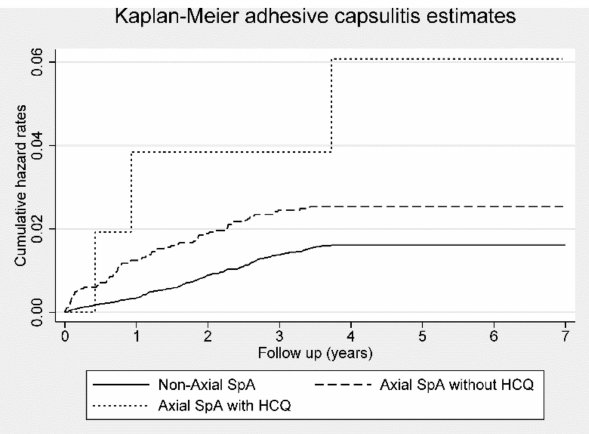
Figure 5. Kaplan–Meier hazard curve for adhesive capsulitis in patients with axial spondyloarthritis (Axial SpA) with or without hydroxychloroquine (HCQ) use and control subjects over the 7-year follow-up